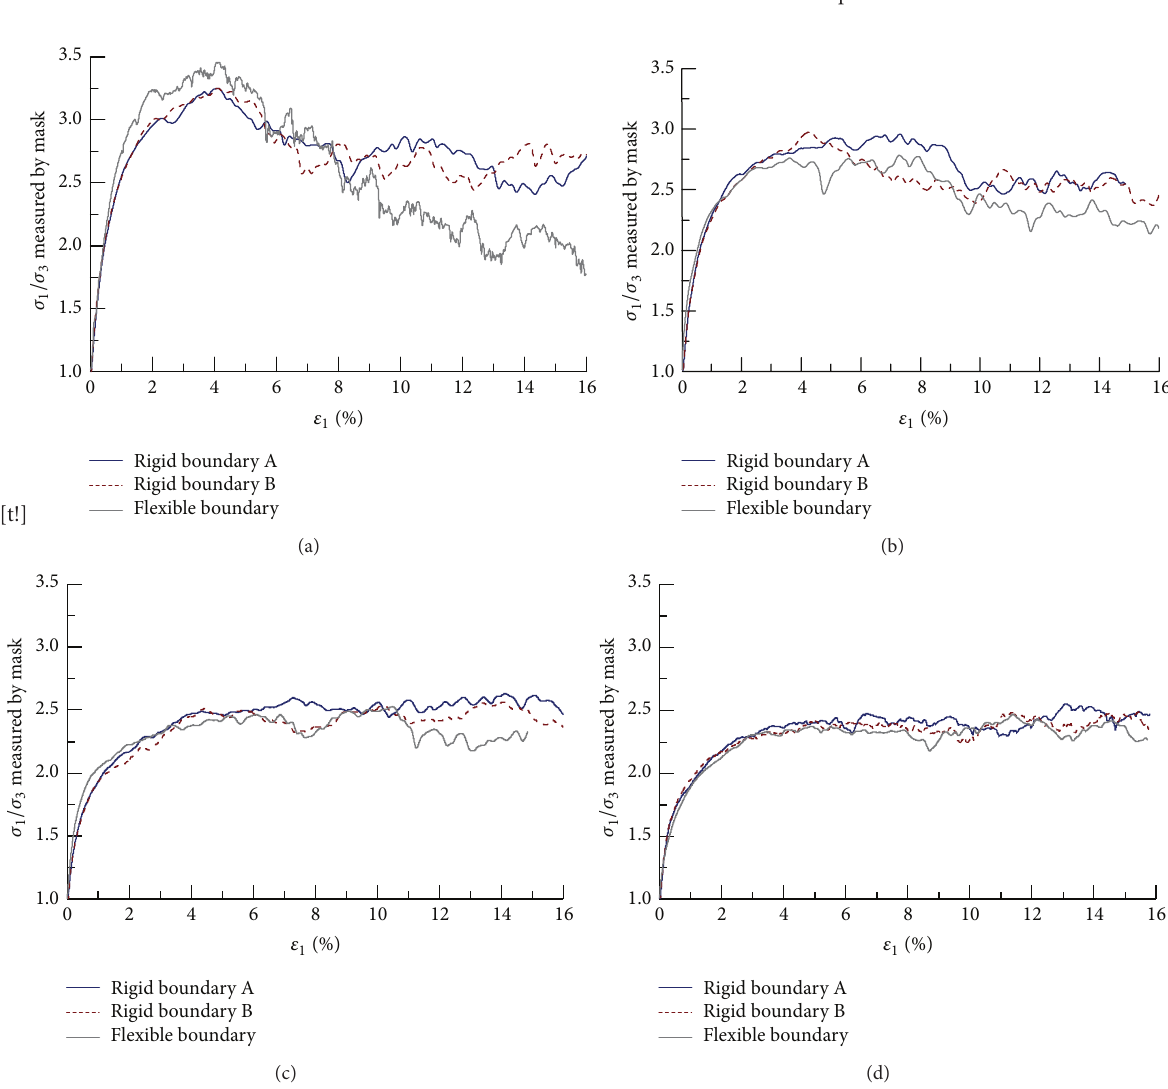
Figure 9: Definition of masks to calculate the stresses inside the specimen.